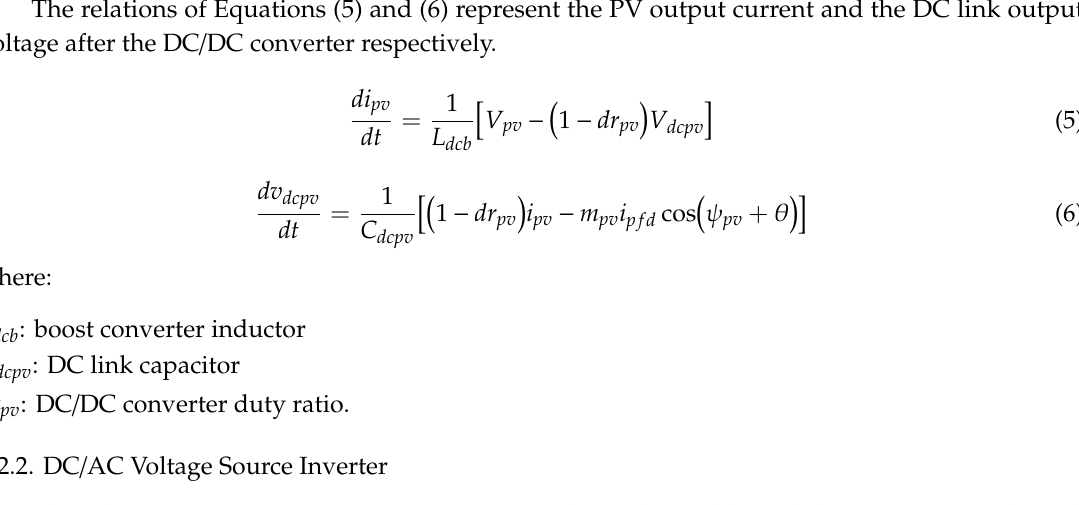
Figure 4. The DC/DC converter circuit. Figure 4. The DC / DC converter circuit.